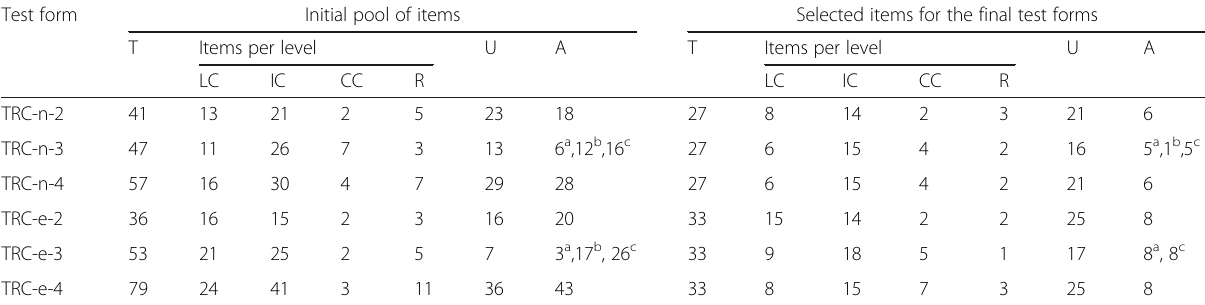
Table 1 Items in each test form of the TRC-n and TRC-e Test form Initial pool of items Selected items for the final test forms